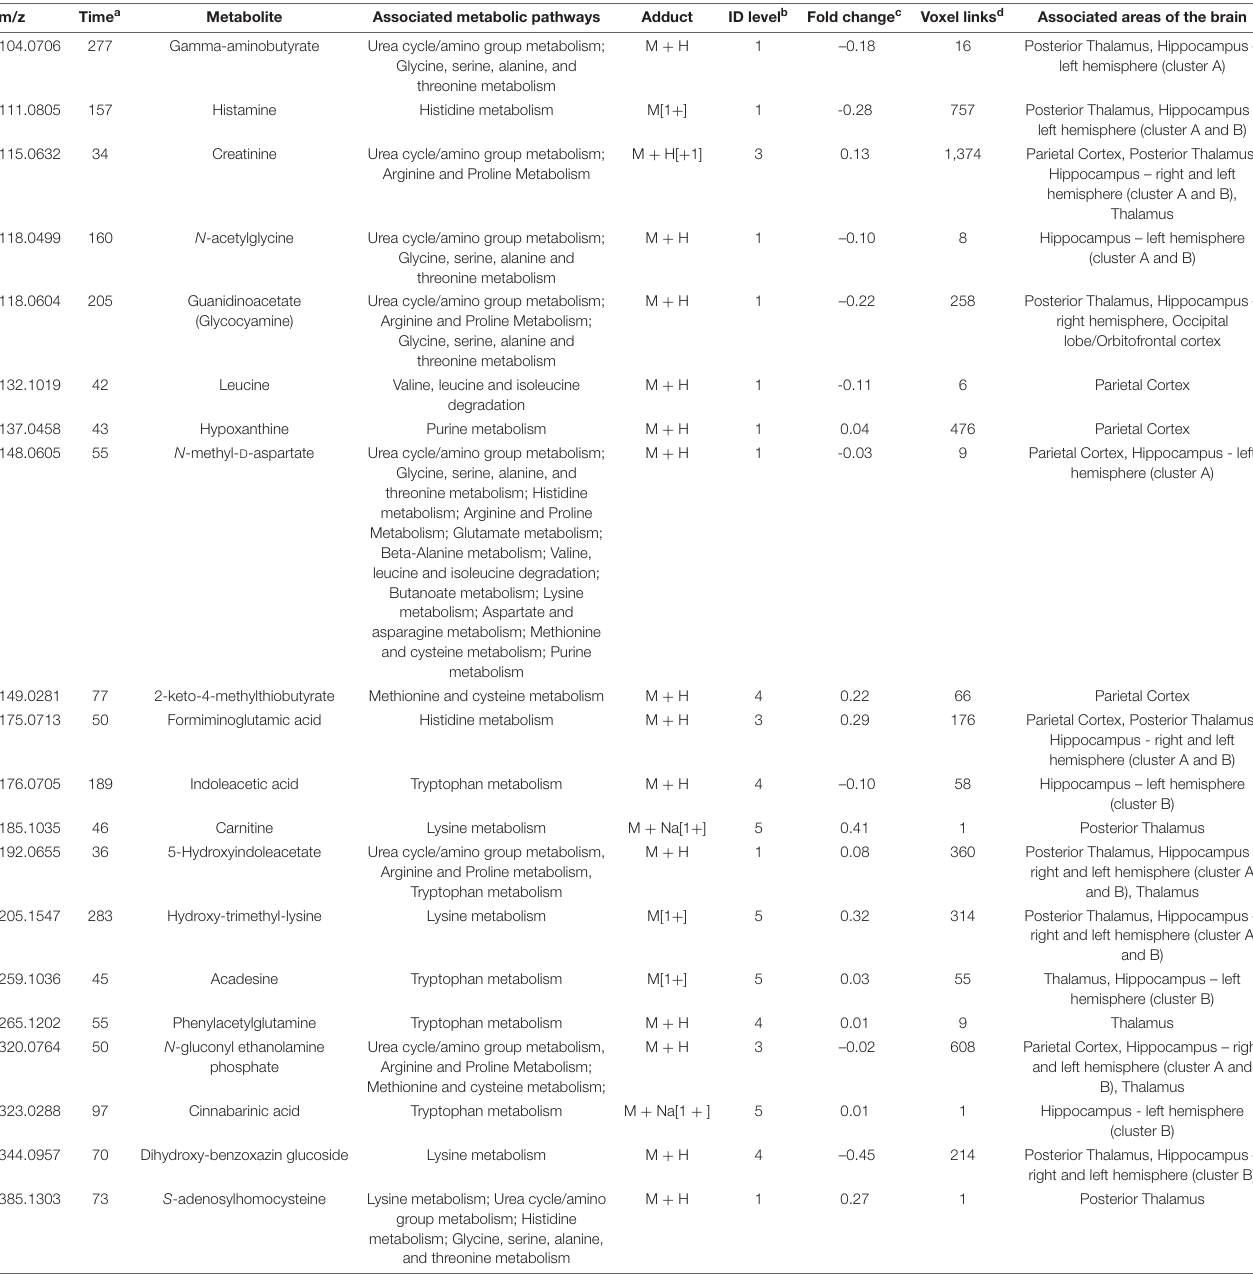
TABLE 3 | Twenty cerebrospinal fluid metabolites that comprise the significant pathways per the Mummichog metabolic pathway